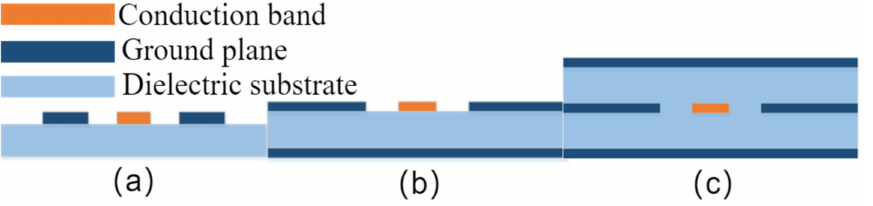
Figure 3. Various waveguide structures. ( a ) Section of traditional coplanar wave; ( b ) cross section of coplanar waveguide with metal substrate; ( c ) cross-sectional view of ribbon coplanar